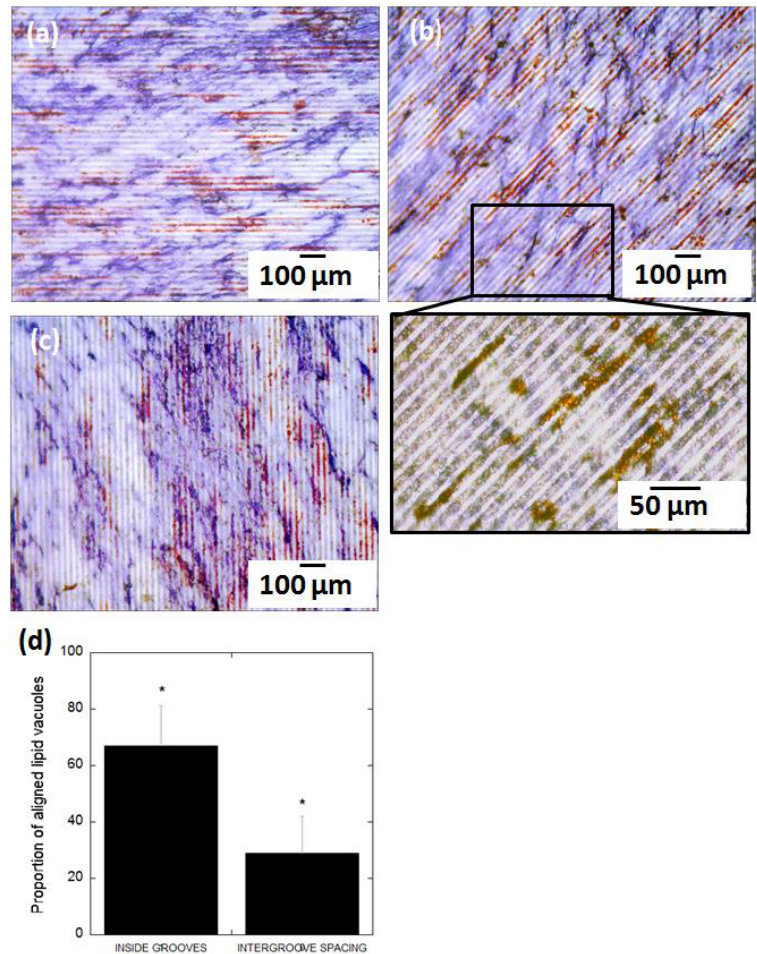
Figure 10. BF images of MSCs differentiated into adipocytes (presence of lipid vacuoles in red) and osteoblasts (AP staining in blue) on GROOVES after 14 days in culture ( a – c ); ( d ) Ratio of clusters of lipid vacuoles confined in the grooves and on the inter-groove spacing (* significance level according to the Student t -test: p < 0.005).